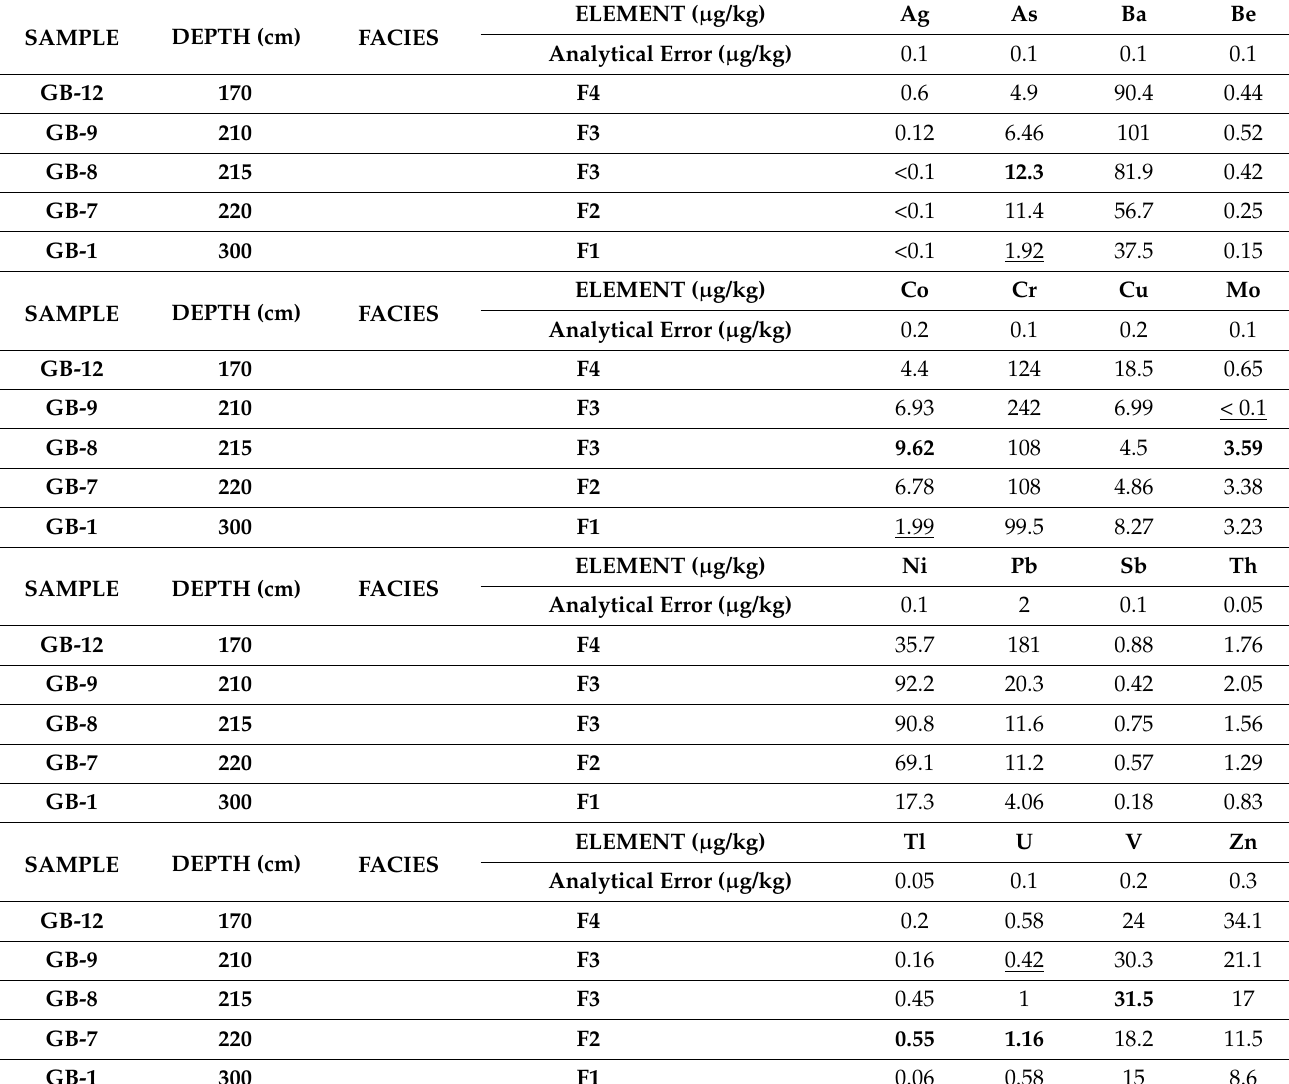
Table 2. Geochemistry of selected samples. Bold: highest value; underlined: lowest value.